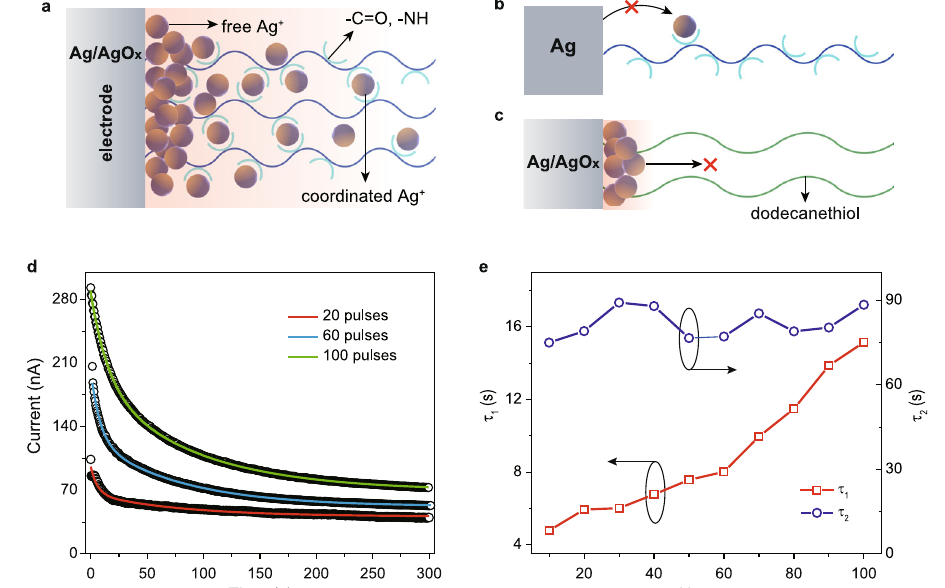
Fig.2|Operationmechanismofthemolecularsynapse.a Schematicshowingthe release and distribution of Ag + in Ag/AgO x //CAAAAKAAAAK//GaO x /EGaIn device under negative voltage. The coordination between Ag + and – C=O, – NH groups enables the long-distancetransportofsilver cations. b Ag + couldn ’ t beactivatedin Ag//CAAAAKAAAAK//GaO x /EGaIn device. Much higher energy is required. c Ag + couldn ’ t migrate across the long alkyl junction in Ag/AgO x ///HS-(CH 2 ) 12 H//GaO x / EGaIn device due to the lack of cation bridges. d Current decay curves of